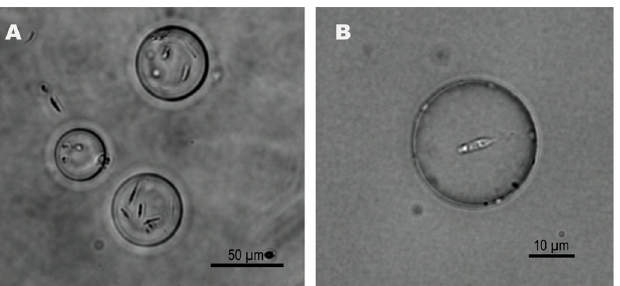
Fig 2. Liposomes encapsulating L . amazonensis promastigotes. The liposome membrane is composed of a EPC-PEG lipid mixture. Five million of L . amazonensis promastigotes per ml were used for the encapsulation process. (A) Liposomes containing multiple parasites. (B) Liposome with a single parasite with its flagellum at the right part of the parasite. Bright field